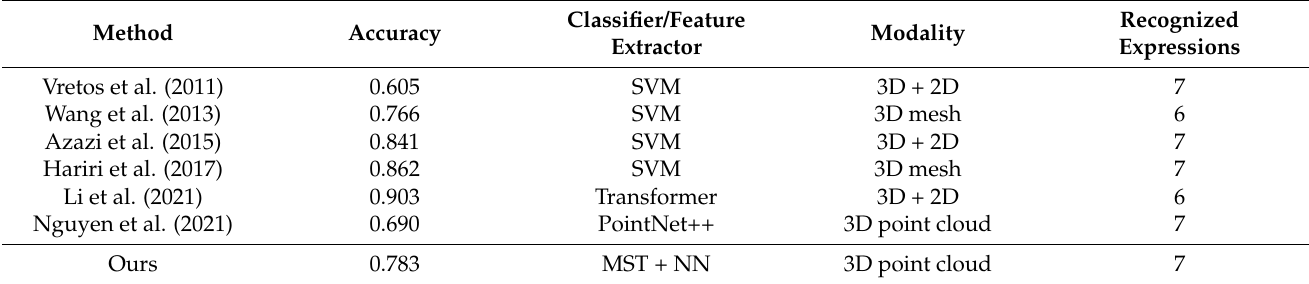
Table 4. Protocol comparison with state-of-art methods on the Bosphorus dataset.